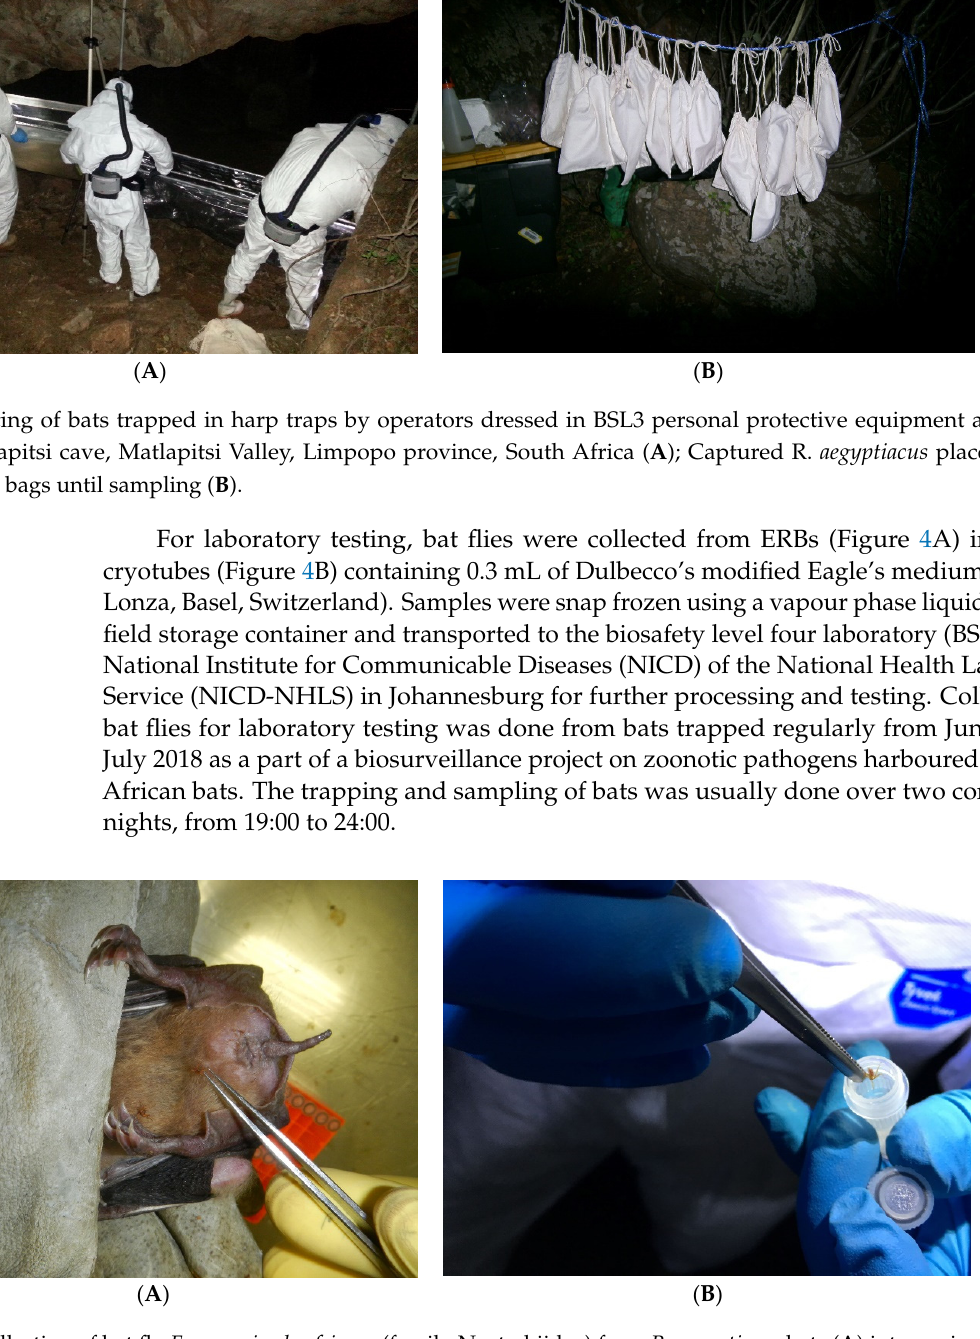
Figure 4. Field collection of bat fly Eucampsipoda africana (family Nycterbiidae) from R. aegyptiacus bats ( A ) into a microtube for transportation to containment facility ( B ).